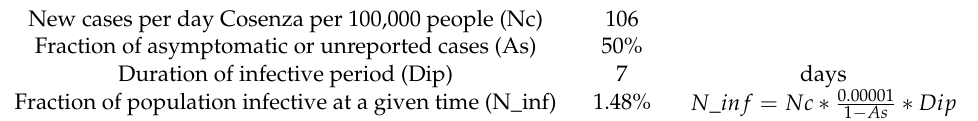
Table 10. Estimate of disease prevalence for the province of Cosenza in Italy (May 2021). New cases per day Cosenza per 100,000 people (Nc) 106 Fraction of asymptomatic or unreported cases (As) 50% Duration of infective period (Dip) 7 days Fraction of population infective at a given time (N_inf)